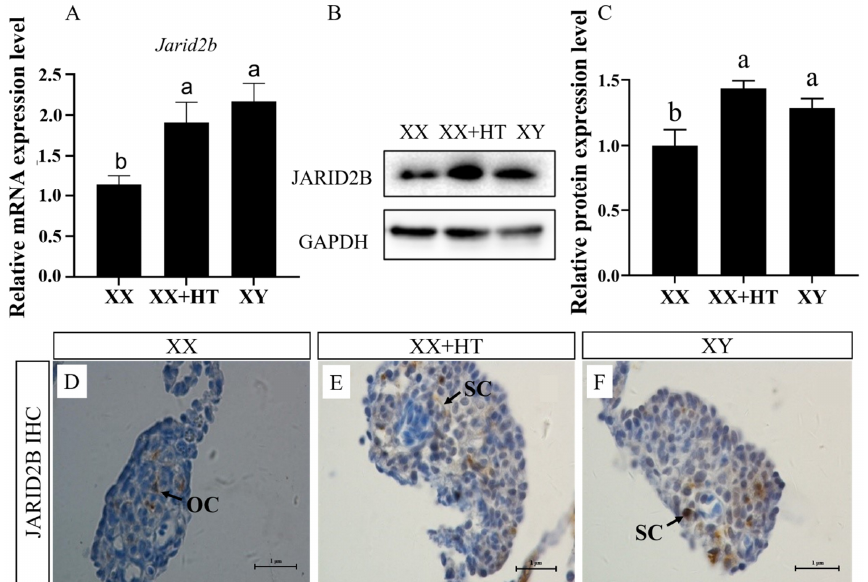
Figure 5. Effects of the high-temperature treatment on the abundance of Jarid2b in Nile tilapia gon- ads at 21 dpf: ( A ): Relative expression of Jarid2b gene at 21 dpf as determined by qRT-PCR. The expression level of Jarid2b in the XX group was set as 1. The different lower-case letters indicate significant differences between treatments ( p < 0.05, ANOVA). XX: control female group; XX + HT: high-temperature-treated female group; XY: control male group. ( B ): Protein expression of Jarid2b at 21 dpf as determined by Western blot. ( C ): Band intensity quantification in Figure 5B was per- formed in Image J software (version 1.8.0.172, National Institute of Mental Health, Bethesda, Mary- land, USA), and GAPDH was used as a loading control. The different lower-case letters indicate significant differences between treatments ( p < 0.05, ANOVA). ( D – F ): IHC results of fish from the XX, XX + HT, and XY groups at 21 dpf. OC: somatic cells; SC: Sertoli cells. The positive signal is brown.